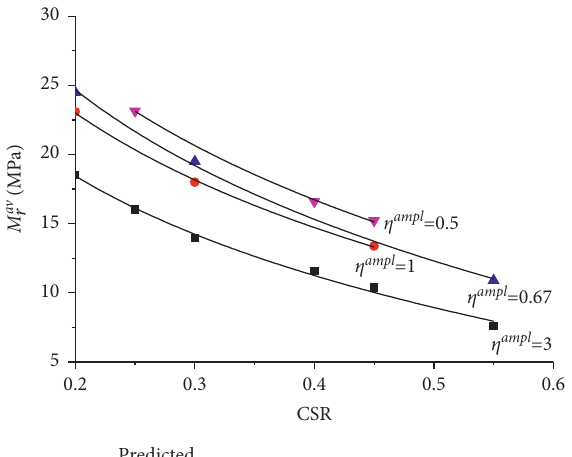
Figure 6: Relationships between resilient modulus and CSR values.